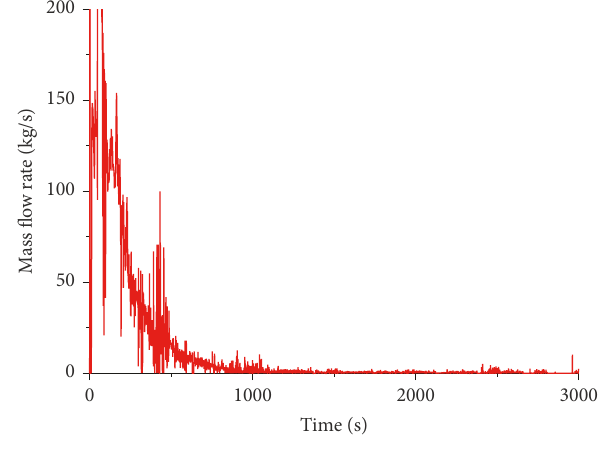
Figure 18: CMT-2 injection